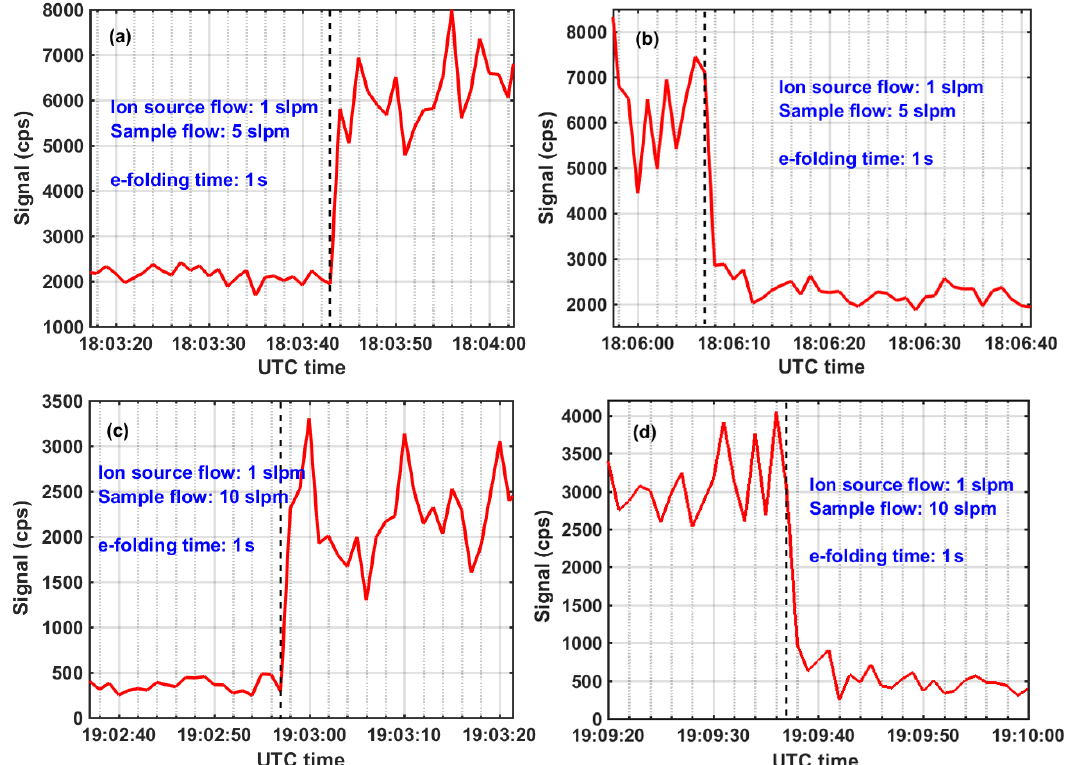
Figure 4. Time series of I(HNO 3 ) − observed when sampling (a, b) 5 standardLmin − 1 or (c, d) 10 standardLmin − 1 humid room air containing some ambient HNO 3 vapor. The ion source flow was 1 standardLmin − 1 . The dashed line indicates the time at which the HNO 3 standard gas was added or shut